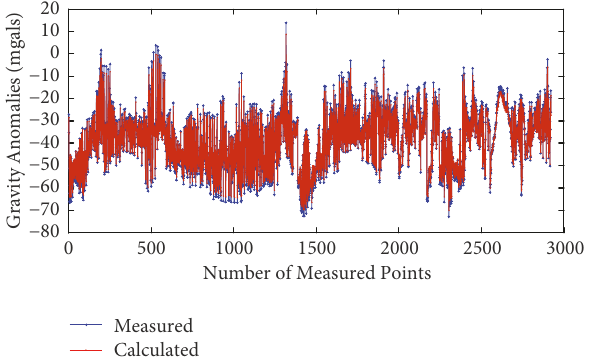
Figure 10: Comparison of present ANN model (blue color) and measured anomalies (red color) for three inputs. Figure 12, we analyze the evolution of errors and Root Mean Square Error (RMSE) against the number of iterations and neurons in the hidden layer (NI and NNHL,